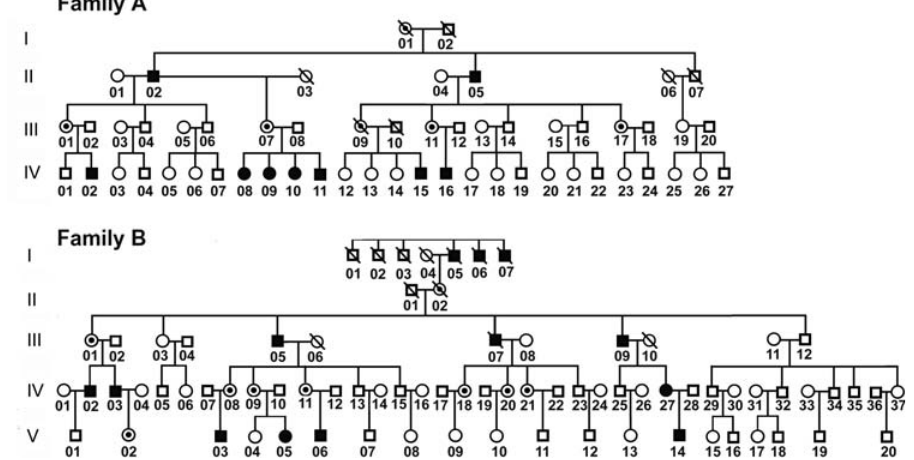
Figure 1. Pedigree structure of the two Chinese families with tooth agenesis. Affection status for pedigrees (females in circles, males in squares) is shown: closed symbols, affected; open symbols, unaffected.